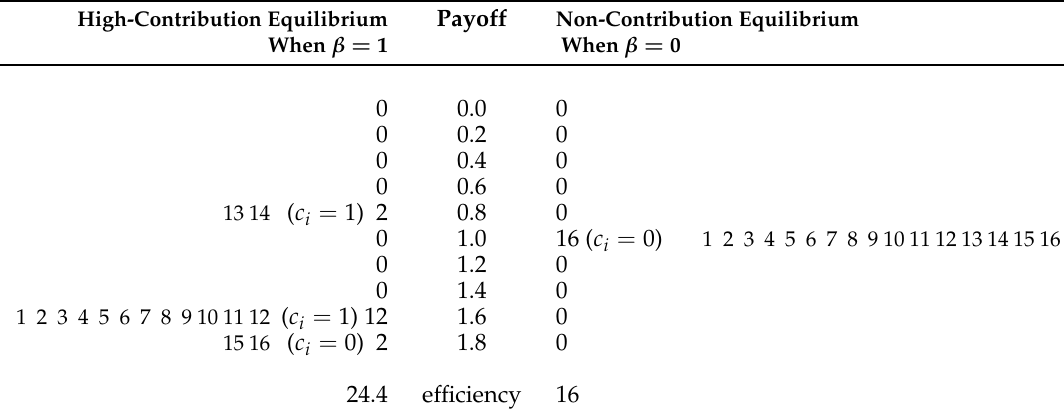
Table 1. Stem-and-leaf plot of individual payoffs for the non-contribution equilibrium (valid for any β ∈ [ 0,1 ] ) and for the high-contribution equilibrium (when evaluated at β = 1). Parameter values are n = 16, s = 4, r = 1.6 and β =